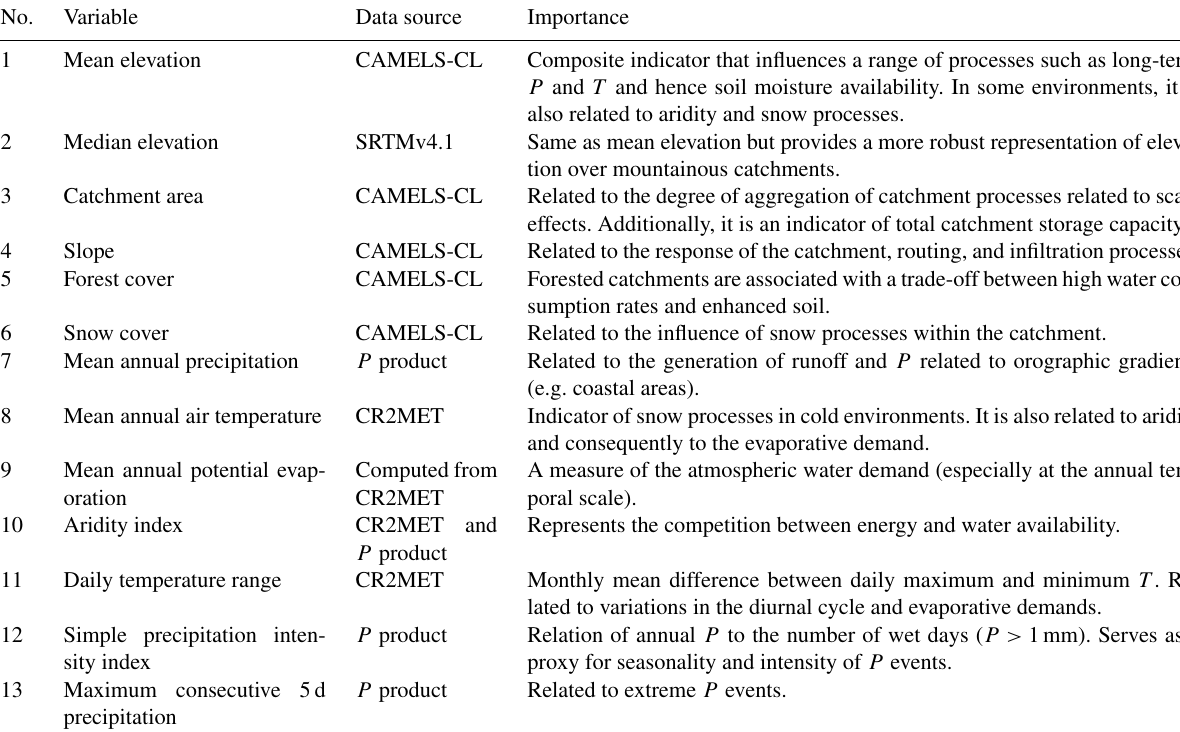
Table 4. Selected climatic and physiographic characteristics to quantify feature similarity between catchments. All variables related to P were computed using the corresponding P product used as an input to the TUWmodel for